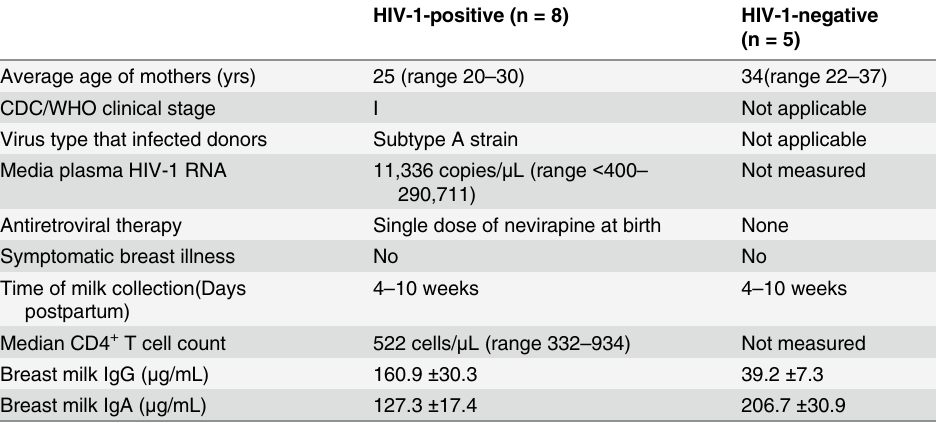
Table 1. Characteristics of breast milk